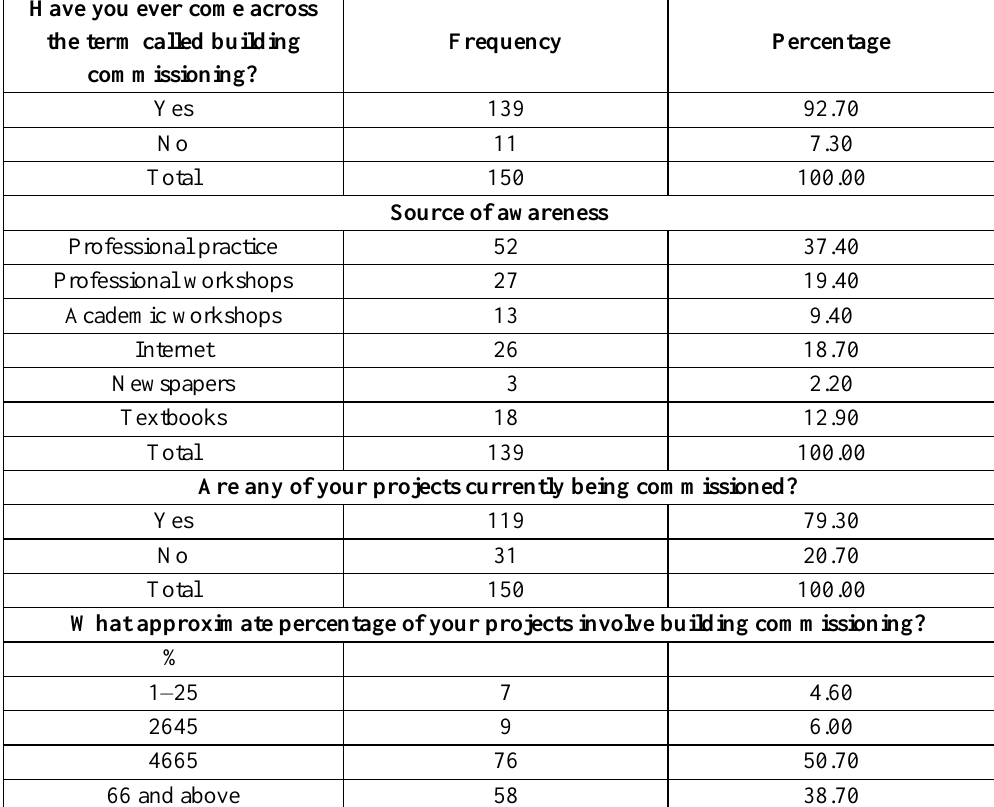
Table 3. Frequency Distribution of Respondents’ Level of Awareness